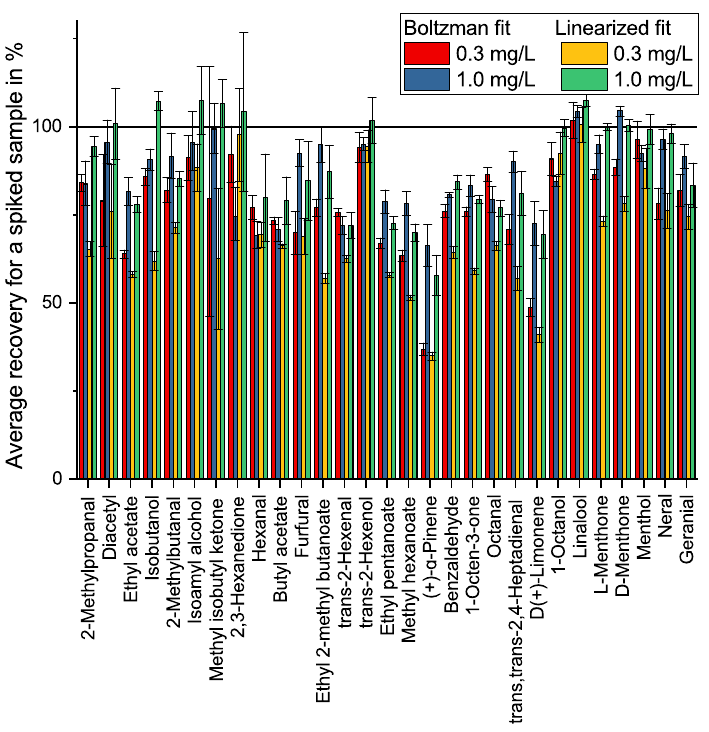
Figure A4. Recovery, as calculated using two different regressions for the calibration, for two different spiked concentrations of all substances analyzed in a flavorless e-liquid, with triplicate